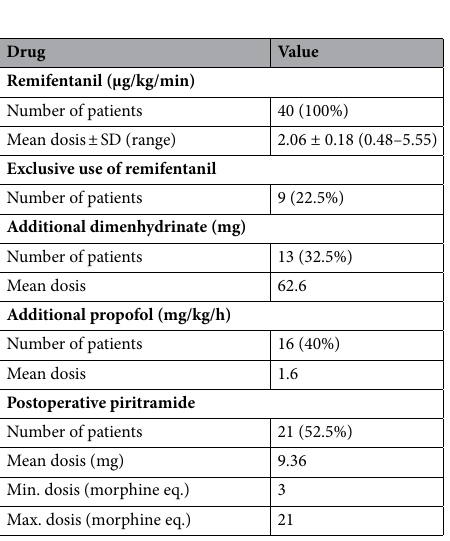
Table 3. Peri-procedural anaesthesia during US-guided HIFU